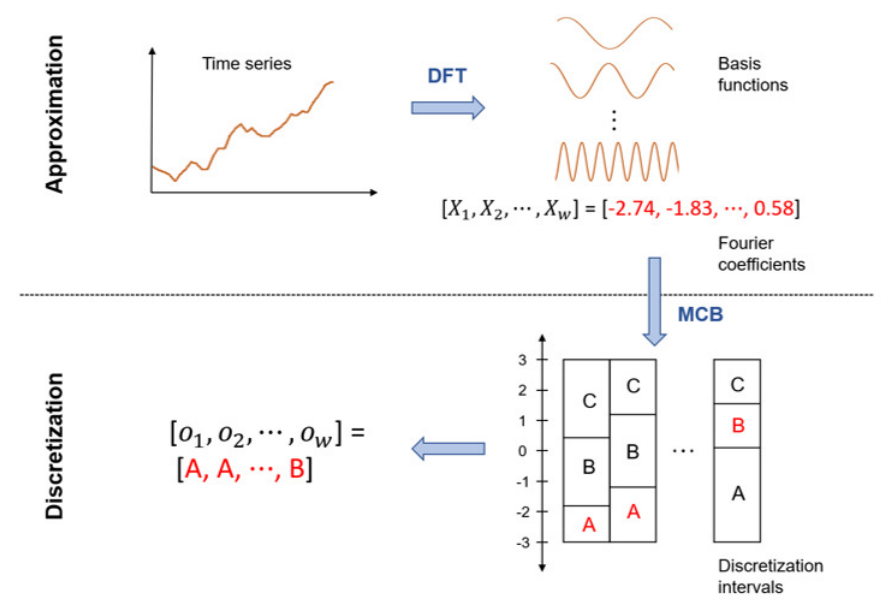
Figure 2. Illustration of the Symbolic Fourier Approximation process. X i denotes a selected Fourier coefficient, and o i represents each output symbol from the